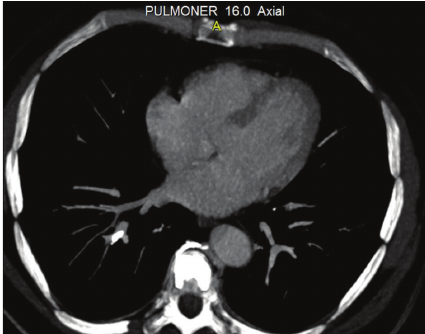
Figure 2: Cement leakage to the azygos vein was detected in thorax CT.